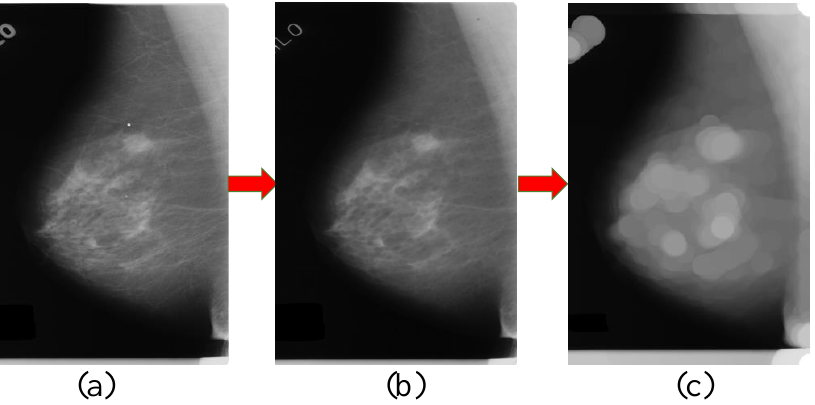
Figure 6. Processing by the mathematical morphology method. Where ( a ) is the mammographic image and there is some noise in the image. ( b ) is the image after the eroding operation on the mammographic image ( a ). Part ( c ) is the image after the dilating operation on image ( b